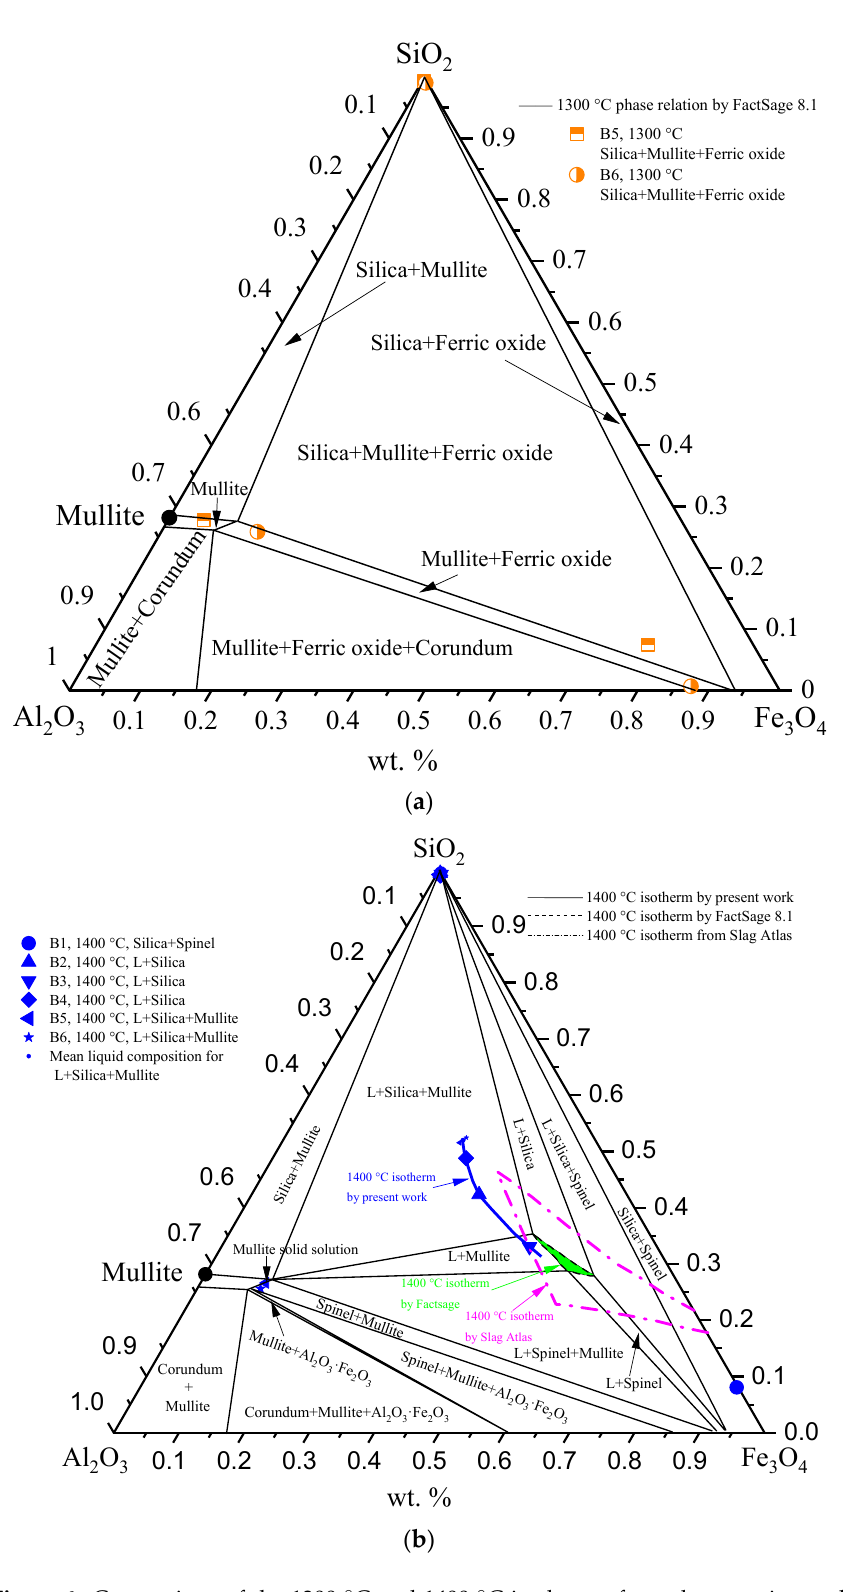
Figure 6. Comparison of the 1300 °C and 1400 °C isotherms from the experimental results with FactSage predictions and the literature results. ( a ) 1300 °C isotherm; ( b ) 1400 °C isotherm.